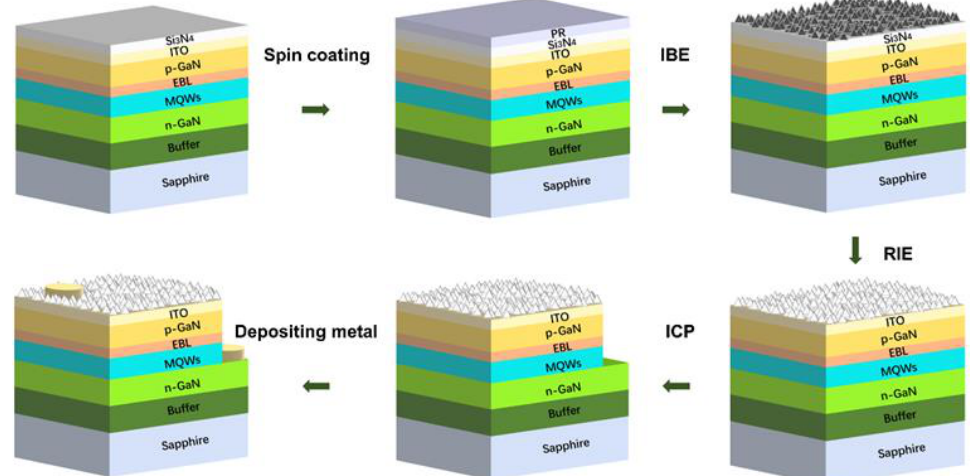
Figure 1. The fabrication process of self-mask-roughened LEDs. Table 1. Essential parameters of IBE for PR carbonization.